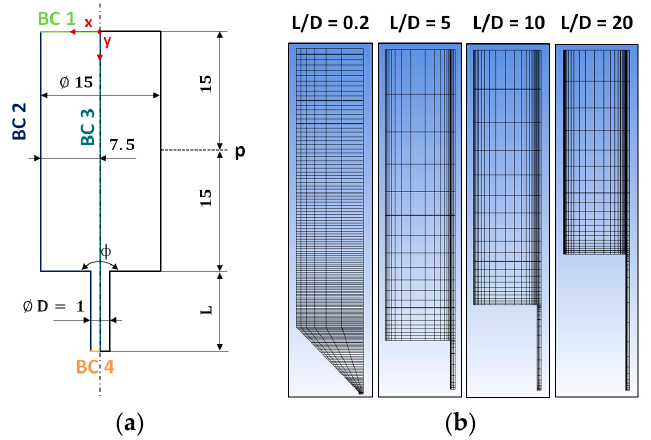
Figure 1. ( a ) Computational fluid dynamic (CFD) simulation setup including boundary conditions (BCs) 1 to 4, dimensions, and position of the pressure transducer (p); ( b ) Meshes for the tapered orifice (L/D = 0.2/1; ϕ = 90°) and three abrupt capillary dies (L/D = 5/1, 10/1, 20/1; ϕ = 180°) utilized in numerical calculations.